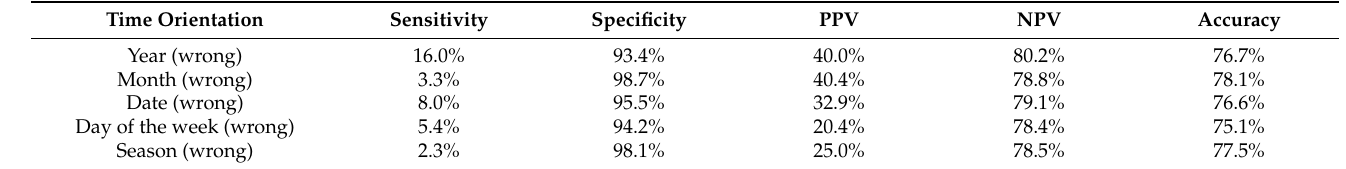
Table 4. Time-orientation tests for the diagnosis of depression (GDS score of ≥ 6).